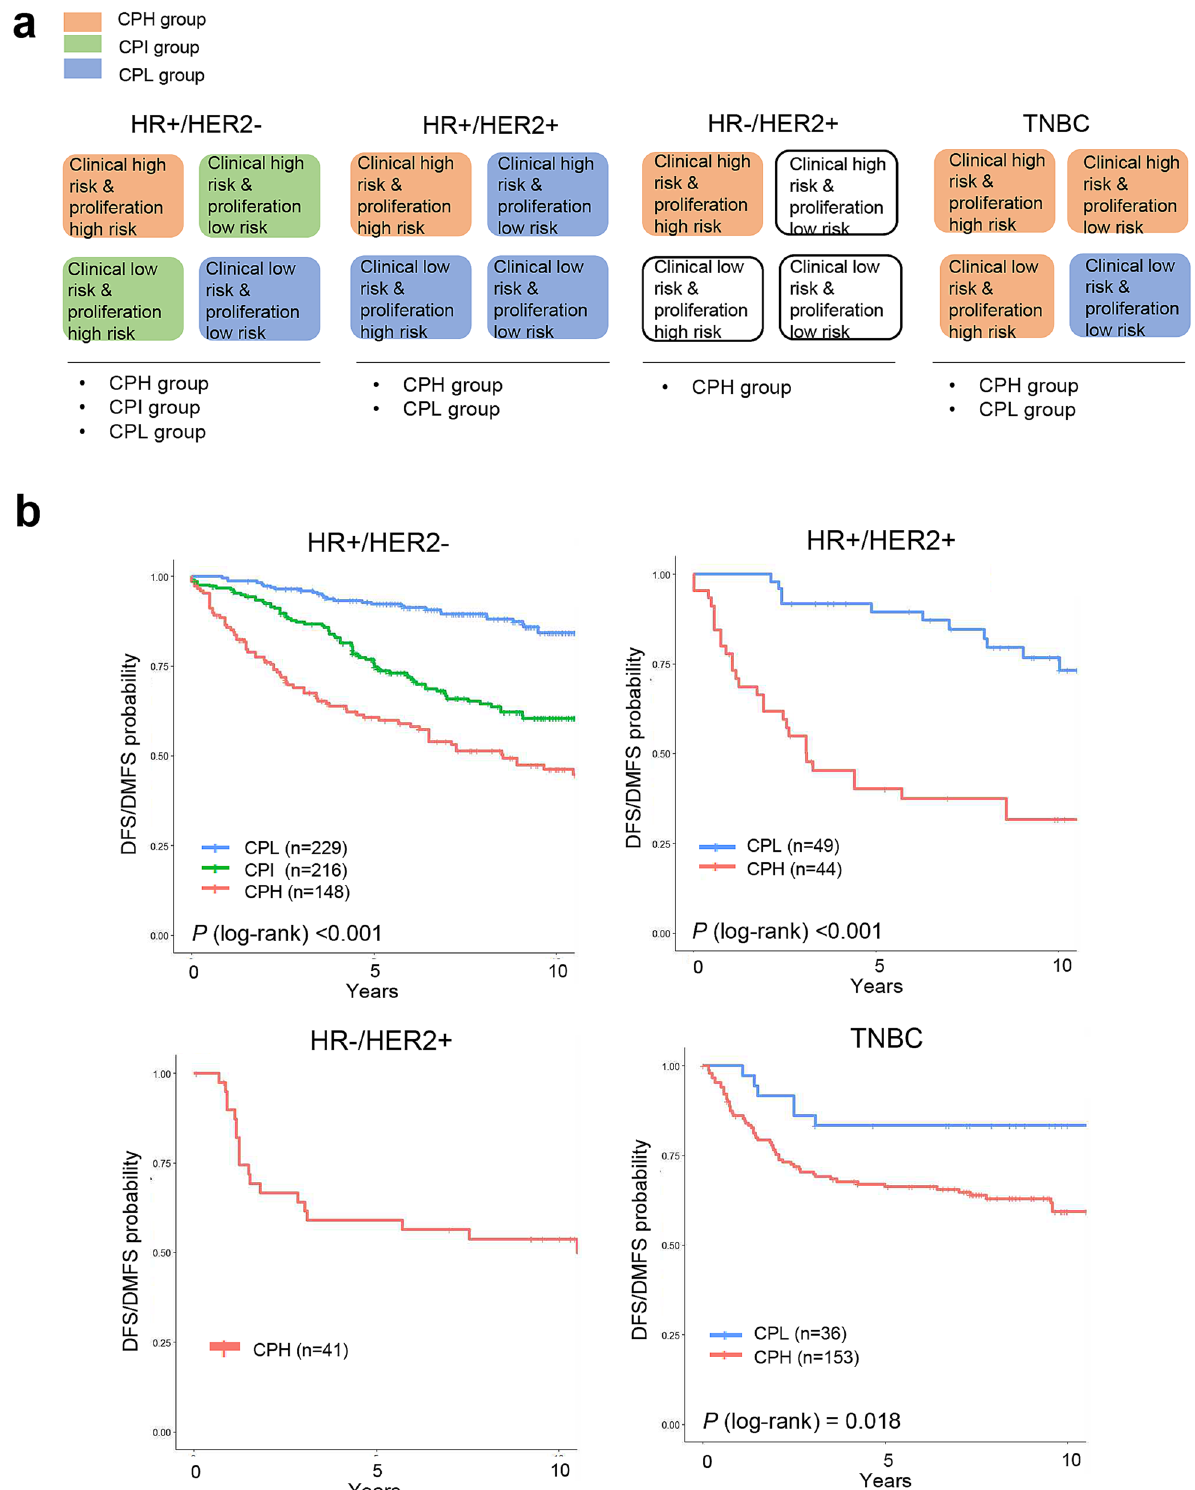
Figure 1. Stratification of patients in the discovery dataset according to clinical risk and proliferation risk. ( a ) Classification of patients with each molecular subtype of breast cancer according to clinical risk and proliferation risk. The four risk groups were regrouped into three risk groups: clinical and proliferation high-risk (CPH), intermediate-risk (CPI), and low-risk (CPL). ( b ) Kaplan–Meier plots for patients in the CPH, CPI, and CPL groups according to each molecular subtype of breast cancer. Differences in survival between groups were assessed using the log-rank